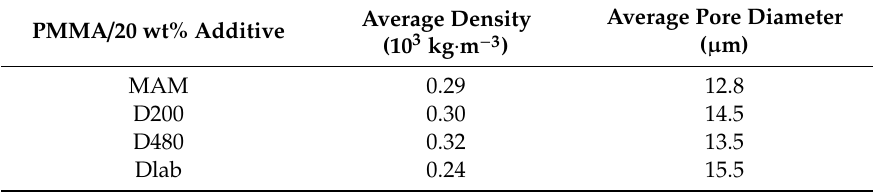
Table 3. Set of experiments I: Characteristics of PMMA-based foams obtained after a one-step batch foaming at a saturation temperature of 80 ◦ C, a saturation pressure of 31.5 MPa and at a gas depressurization speed of ∆ P / dt~12 MPa · min − 1